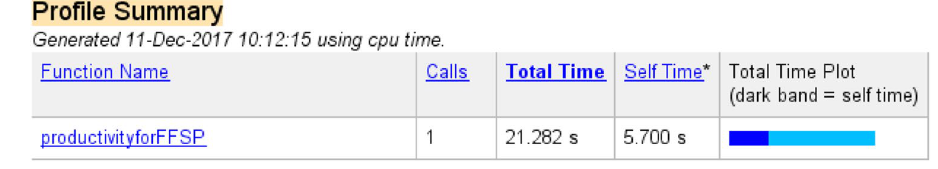
Fig. 3 Running time of produc- tivity prediction